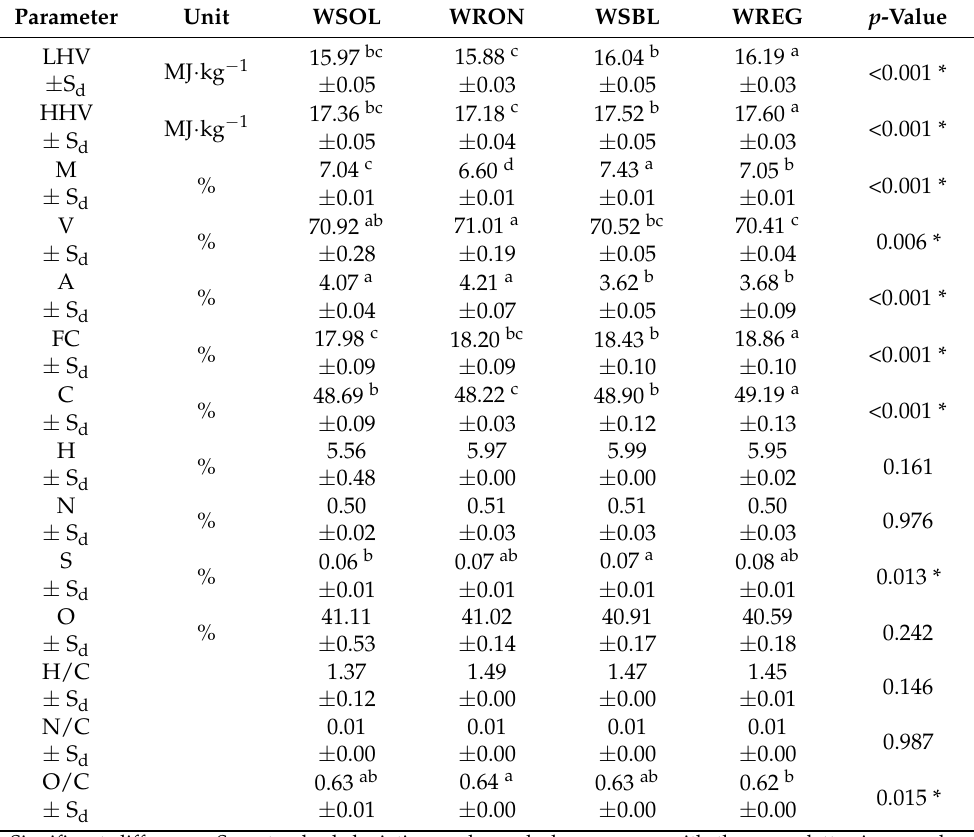
Table 3. Technical and elemental analysis for waste shoots of selected grape varieties. Parameter Unit